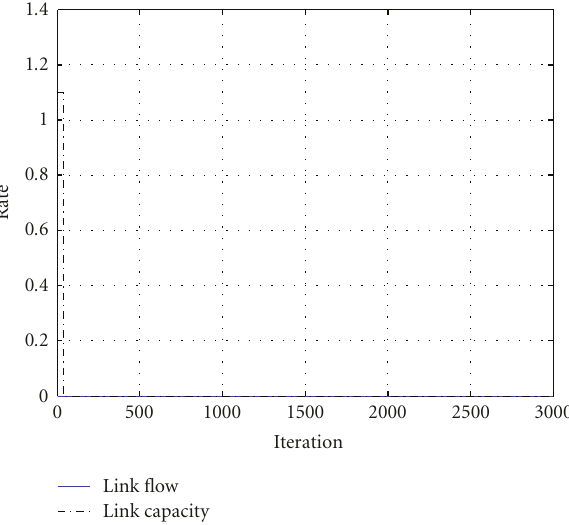
Figure 9: The flow and capacity of links 4, 5, 7, 8, and 9.